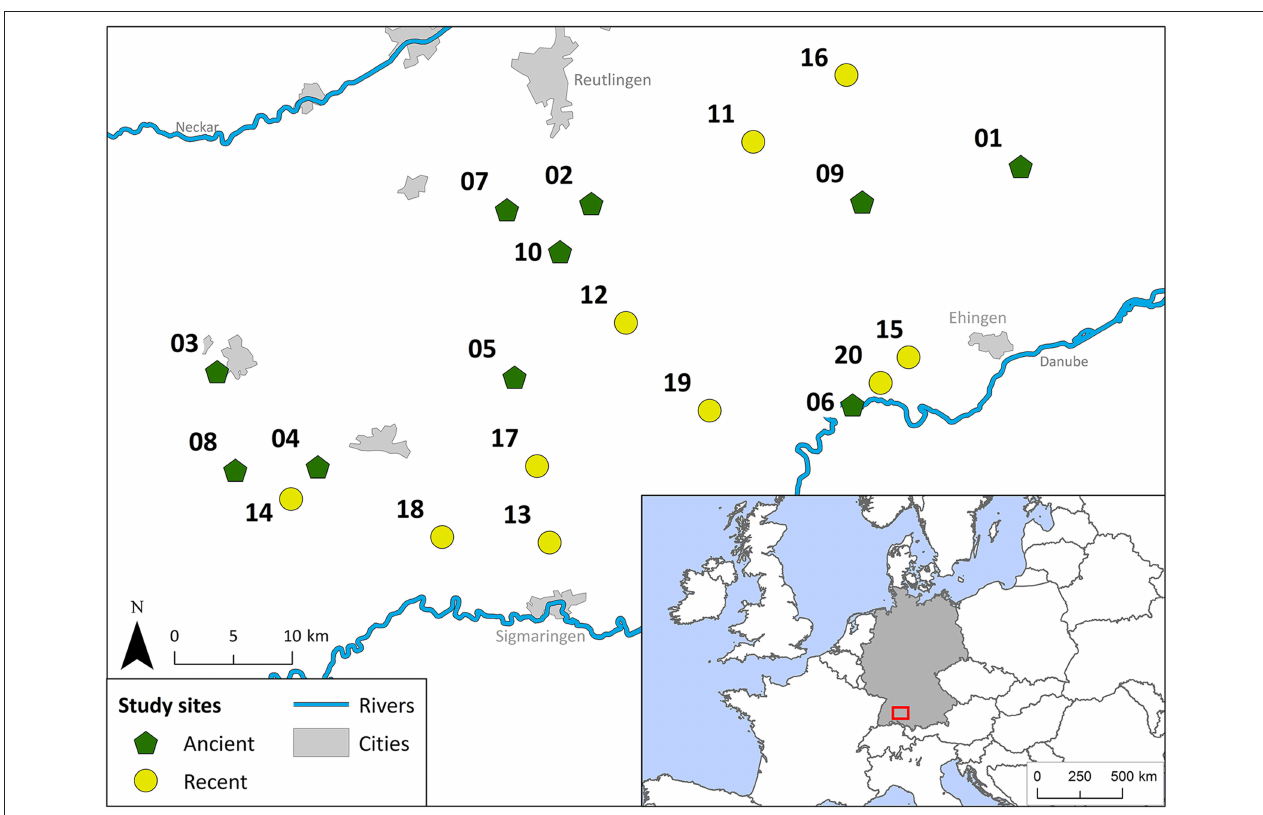
FIGURE 1 | Geographic location of all 20 study sites on the Swabian Alb within the administrative district of Tübingen in Southwest Germany. Ancient grasslands are shown with a green pentagon (1–10) and recent grasslands with a yellow circle